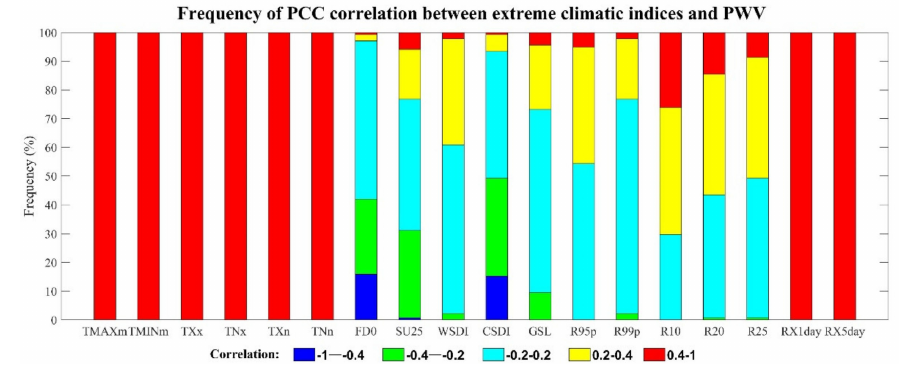
Figure 11. Statistical results of the Pearson correlation coe ffi cients of PWV with extreme temperature indices, where TMAXm and TMINm represent TMAXmean and TMINmean,